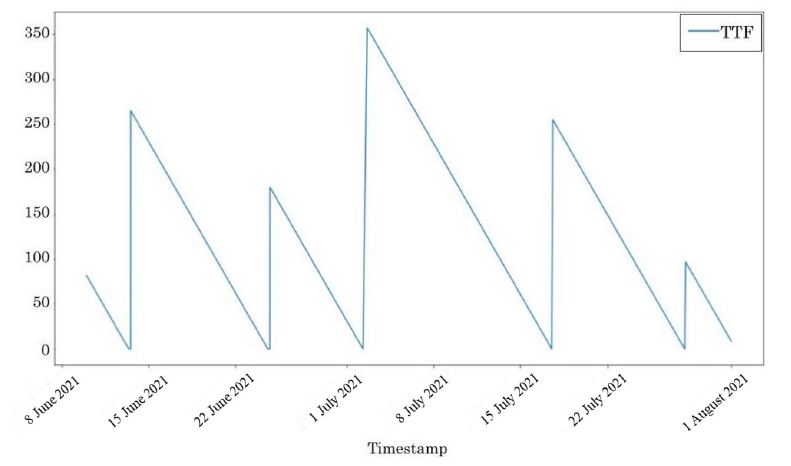
Figure 6. TTF estimation for WT